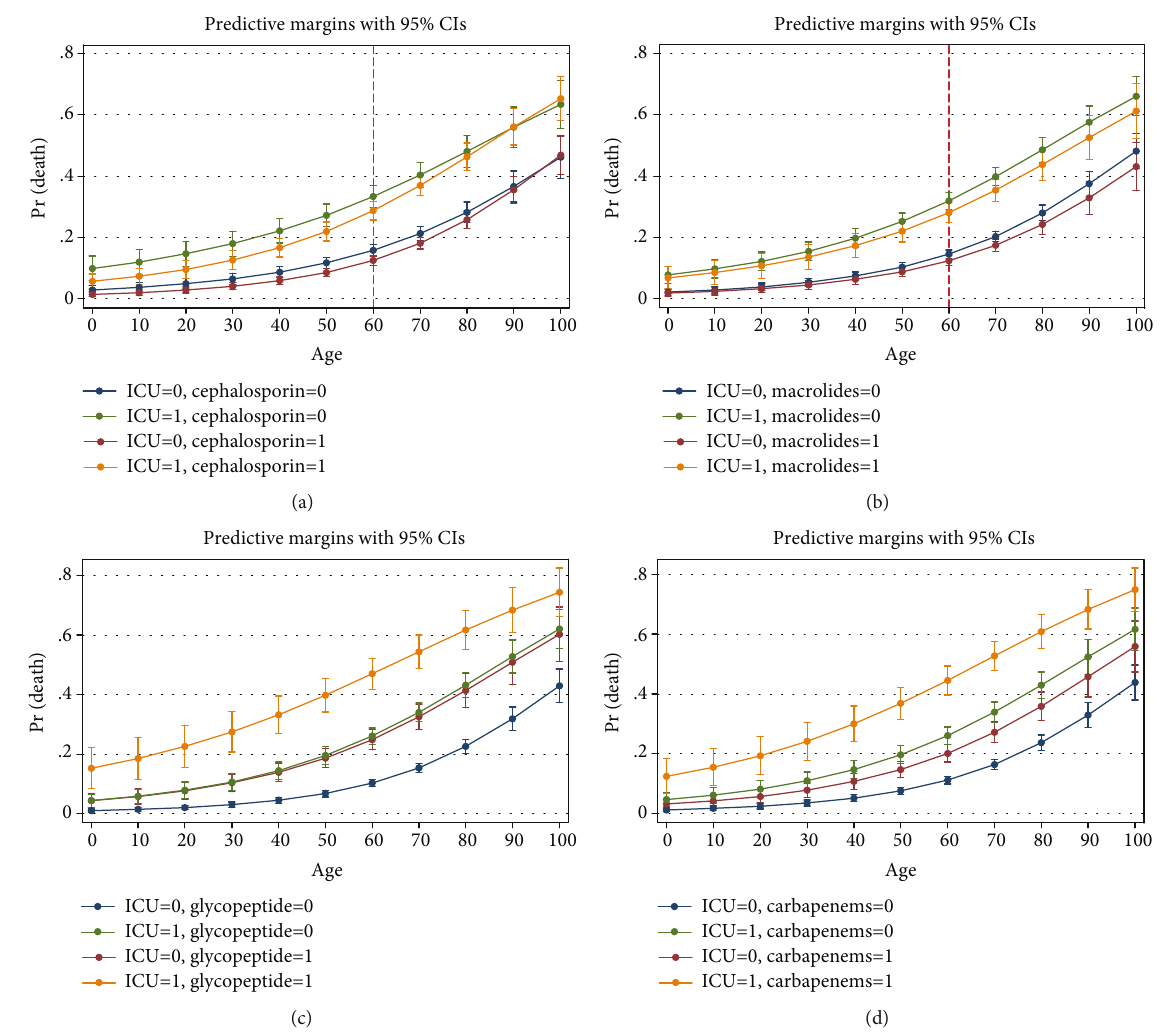
Figure 8: Association of cephalosporins (a), macrolides (b), glucopeptides (c), and carbapenems (d) with probability of death based on age and ICU admission (from logistic regression of Table 3, step